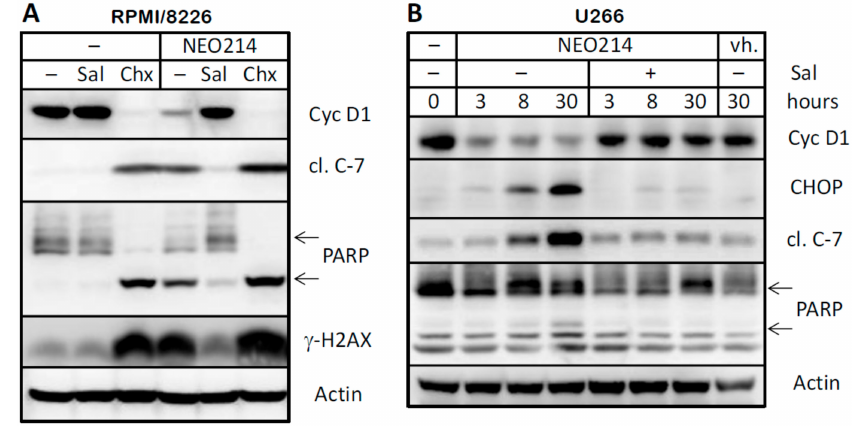
Figure 8. Salubrinal prevents NEO214-induced ER stress and apoptosis. ( A ) RPMI/8226 cells were treated with or without 100 µ M NEO214 in the presence or absence of 75 µ M salubrinal (Sal) for 24 h. In parallel, 50 µ M cycloheximide was included as a positive control for inhibition of protein synthesis and resulting apoptosis. ( B ) U266 cells were treated with or without NEO214 in the presence or absence of salubrinal for different times. In all cases, lysates were prepared and subjected to Western blot analysis with specific antibodies as indicated. Actin was used as the loading control. Cyc D1: cyclin D1; cl. C-7: cleaved/activated caspase 7. Two arrows point to full-length and cleaved form of PARP. vh.: vehicle.